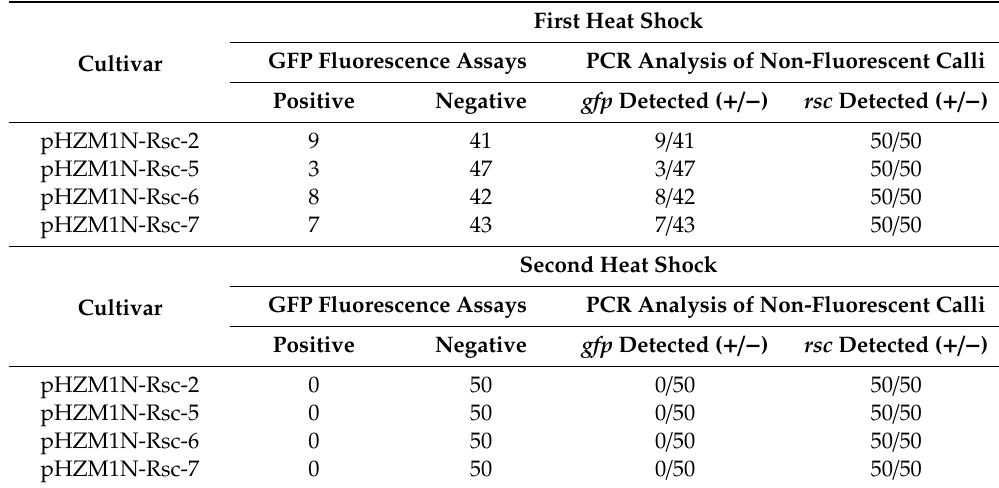
Table 2. GFP fluorescence assays and PCR analysis of the auto-excision marker in calli.